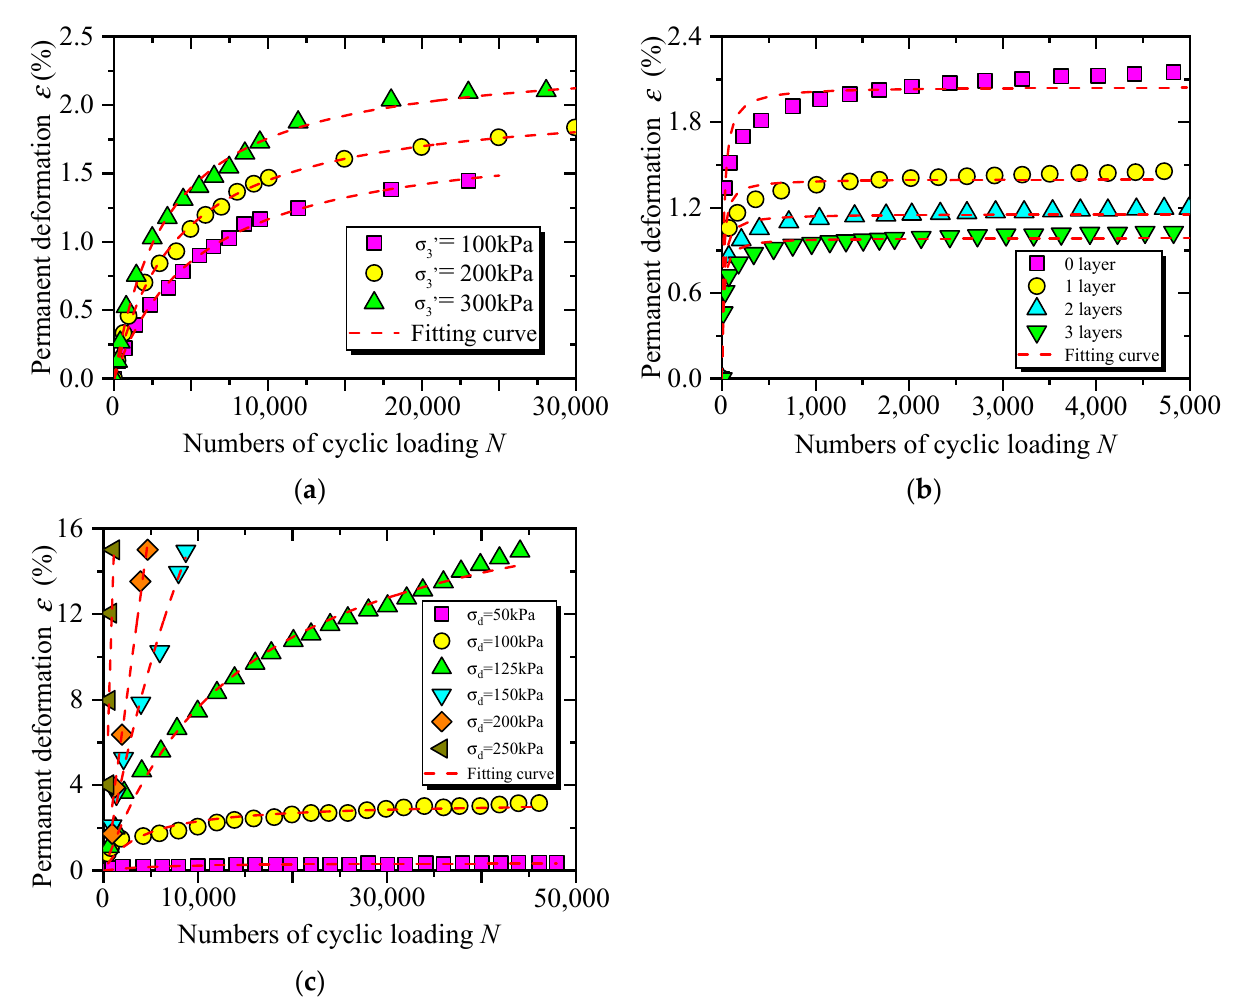
Figure 14. Model validation. Test data were extracted from: ( a ) Li et al. [35], ( b ) Wang et al. [37], and ( c ) Mei et al. [43].